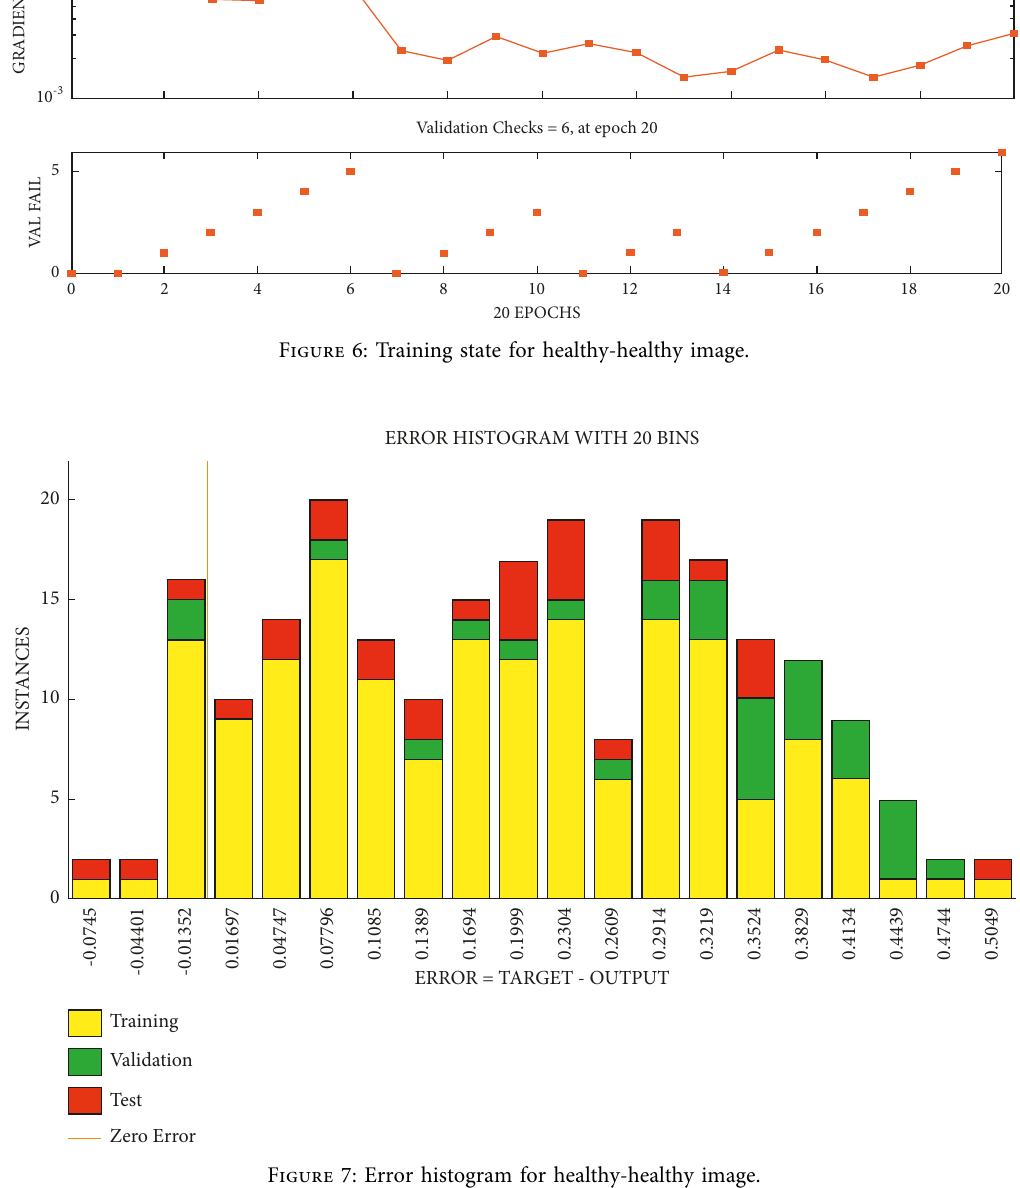
Figure 7: Error histogram for healthy-healthy image.